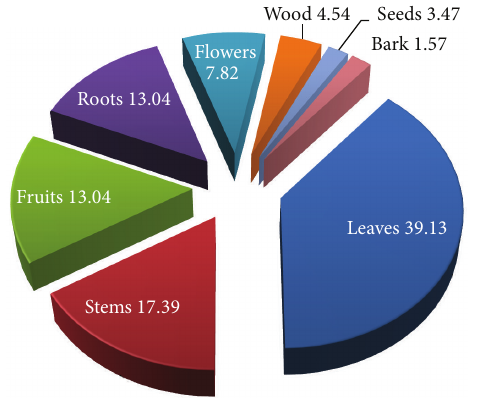
Figure 2: Percentage of plant parts used for medicinal and other important